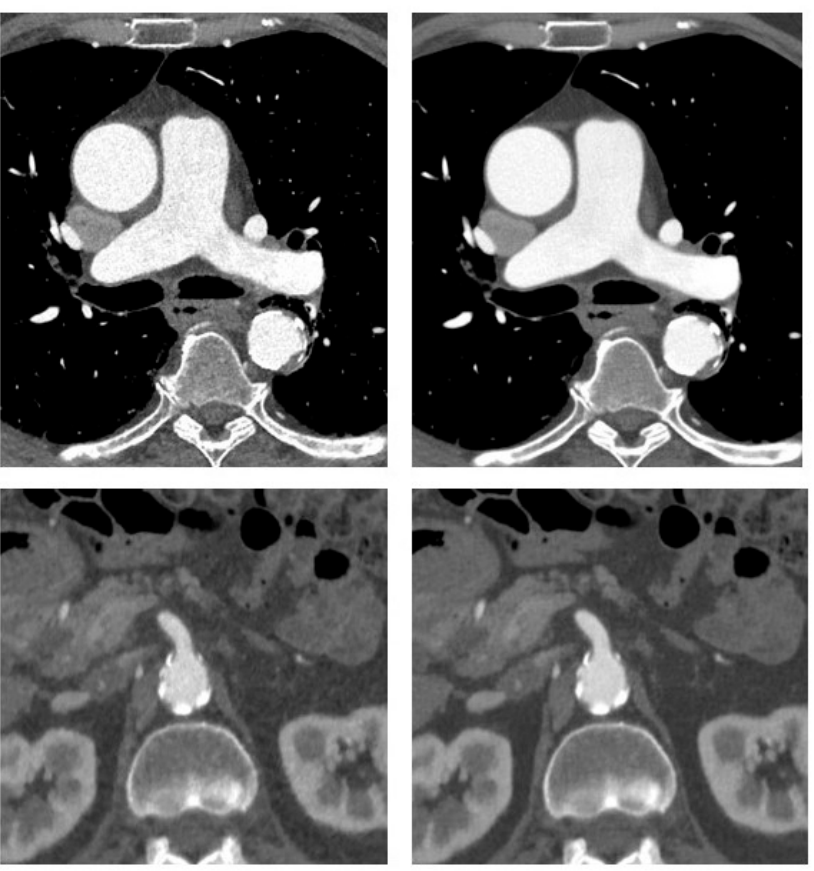
Figure 2. CT angiography of the aorta in a 72-year-old man with coronary artery disease and suspected aneurysm of the ascending aorta. Transverse sections at the level of the ascending aorta and superior mesenteric artery origin are shown with adaptive statistical iterative reconstruction V (ASIR-V 60%, left ) and deep-learning-based reconstruction (DLIR-H, right ). There is mild aneurysmatic dilatation of the ascending aorta with a maximum diameter of 4.3 cm. Some atherosclerotic plaque along the descending aorta is also noted.